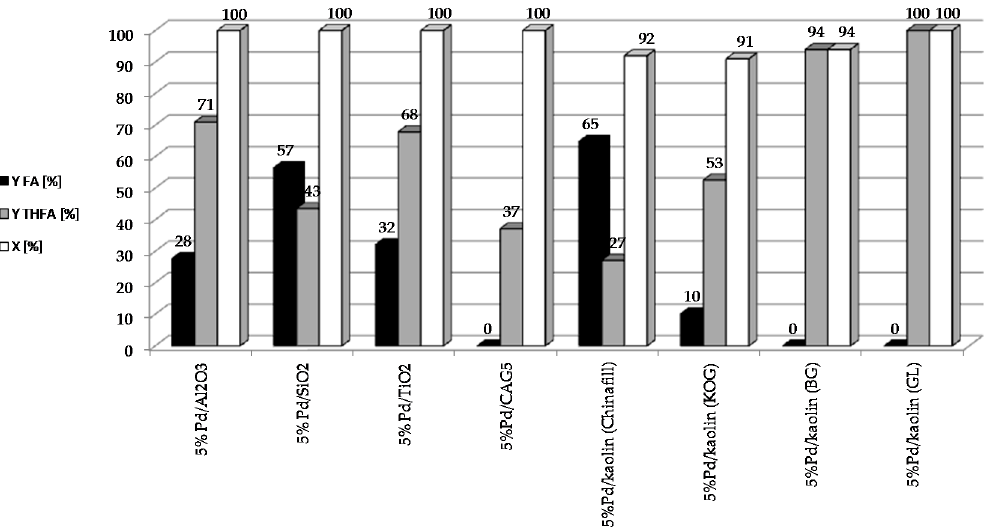
Figure 2. Effect of the type of support used for the reduction of furfural on the catalytic properties of heterogeneous systems containing 5 wt. % of palladium.